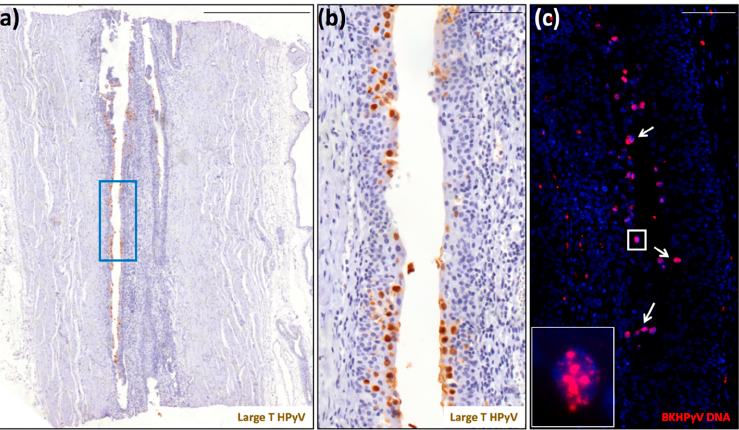
Figure 2. Detection of polyomavirus large-T antigen and BKPyV DNA in the ureter of a native kidney removed from patient 9 due to the presence of a clear cell renal cell carcinoma. ( a ) Scan of a tissue section stained for large-T antigen (scale bar: 500 μ m). ( b ) Region corresponding to the blue square highlighted in panel (a) (scale bar: 100 μ m). This section was counterstained with hematoxylin to visualize cell nuclei. ( c ) Serial section stained for BKPyV genome by fluorescent in situ hybridization (FISH) (red) (inset: magnification of the white square). The white arrows indicate FISH-BKPyV-positive nuclei. This section was counterstained with 4 ′ ,6-diamidino-2-phenylindole (DAPI) (blue) to visualize cell nuclei (scale bar: 100 μ m).